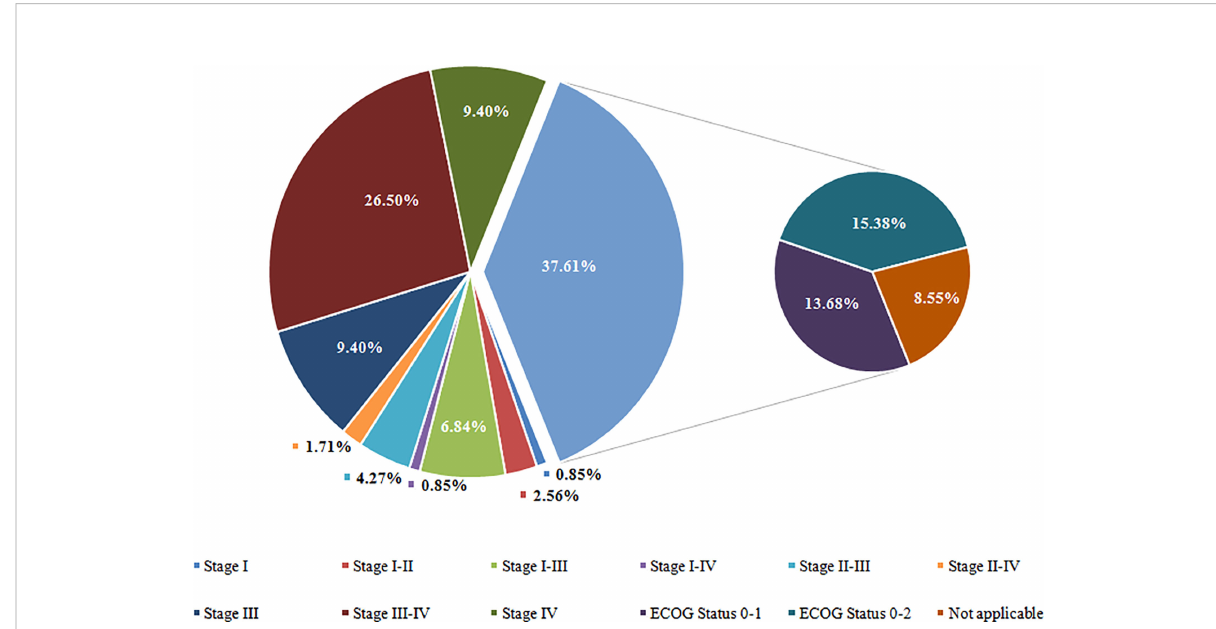
FIGURE 4 Overview of Tumor Stage for Participate of Included Trials. Stage I including stage I, IA, and IB; Stage II including stage II, IIA, and IIB; Stage III including stage III, IIIA, and IIIB; Stage IV including stage IV, IVA, and IVB. ECOG, Eastern Cooperative Oncology